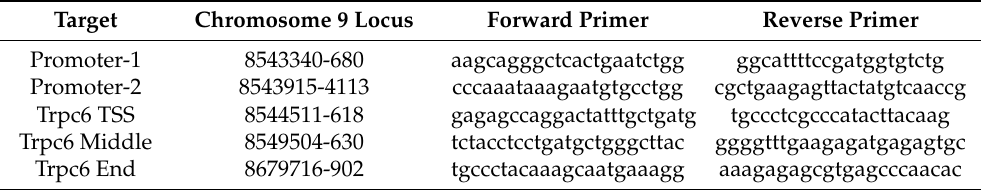
Table 2. Primers for the ChIP-qPCR for the promoter, TSS, and intragenic sites within the Trpc6